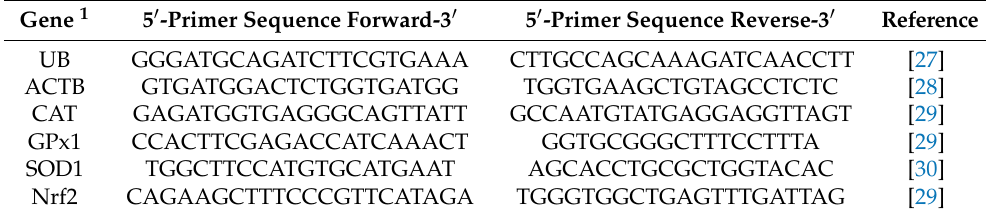
Table 2. Genes, forward and reverse primers, for gene expression analysis by quantitative real-time PCR. Gene 1 5 (cid:48) -Primer Sequence Forward-3